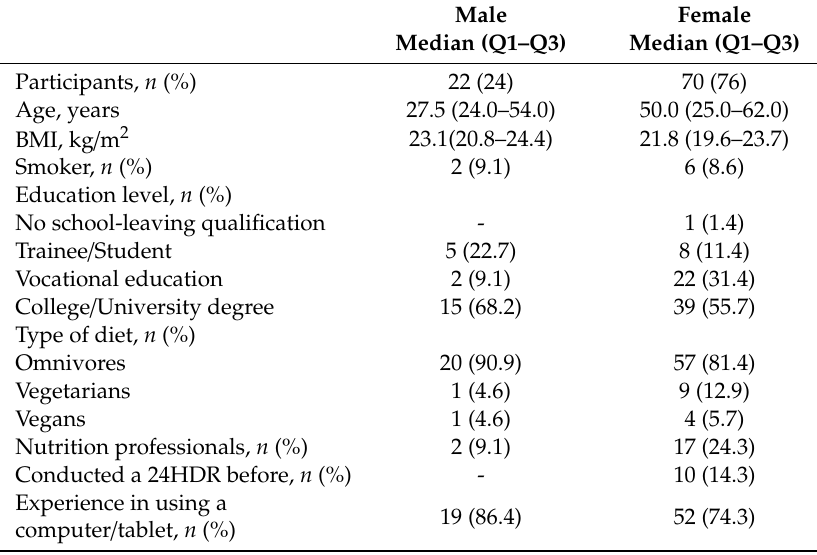
Table 1. Characteristics of study participants who completed an evaluation questionnaire on myfood24- Germany ( n = 92).